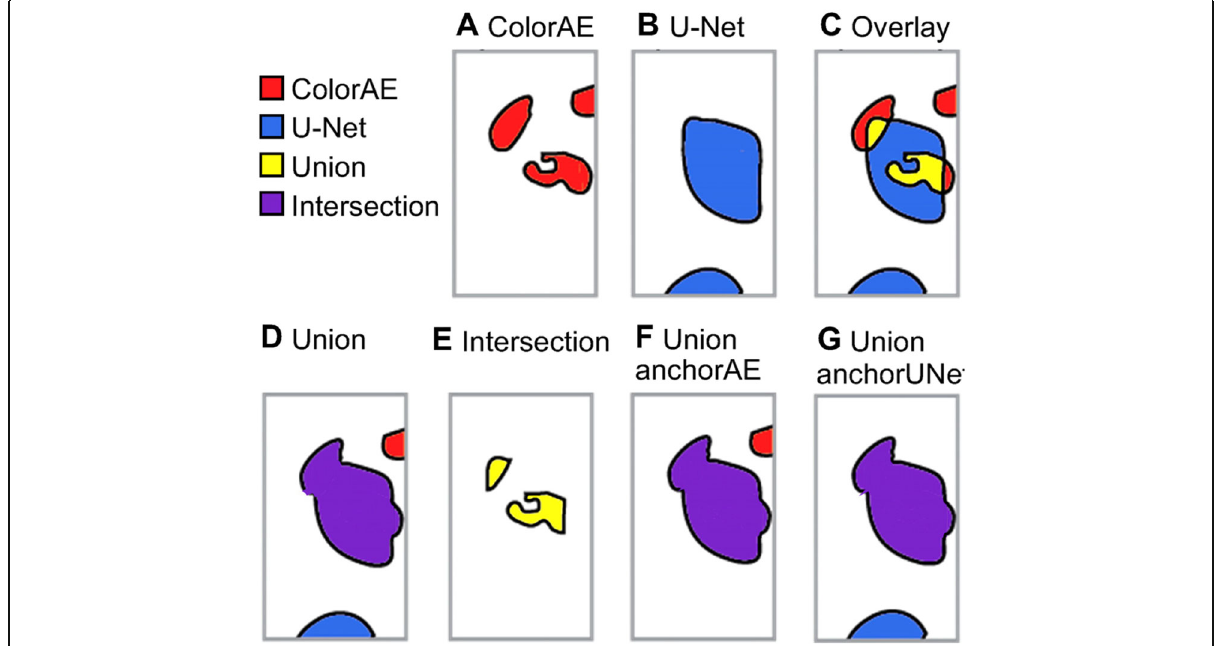
Fig. 5 ColorAE, U-Net, and ensemble predictions. All panels show predictions from the same cell class from the same input image. Top panel: a - c ColorAE and U-Net predictions are shown for a single cell class are shown individually and overlaid. Bottom panel, ensemble methods : d Union includes predictions from both ColorAE (red) and U-NET (blue): any overlapping predictions (detected by both algorithms) are merged into a single mask (purple). e Intersection includes the pixels detected by both algorithms, while excluding any areas of the mask detected by only one algorithm. f UnionanchorAE includes all masks detected by ColorAE and U-Net masks that intersect a ColorAE mask (union) while excluding U- Net masks that do not intersect a ColorAE mask (only detected by the U-Net). g UnionanchorUNet includes all masks detected by U-Net and ColorAE masks that intersect a U-Net mask (union) while excluding ColorAE masks that do not intersect a U-Net mask (only detected by the